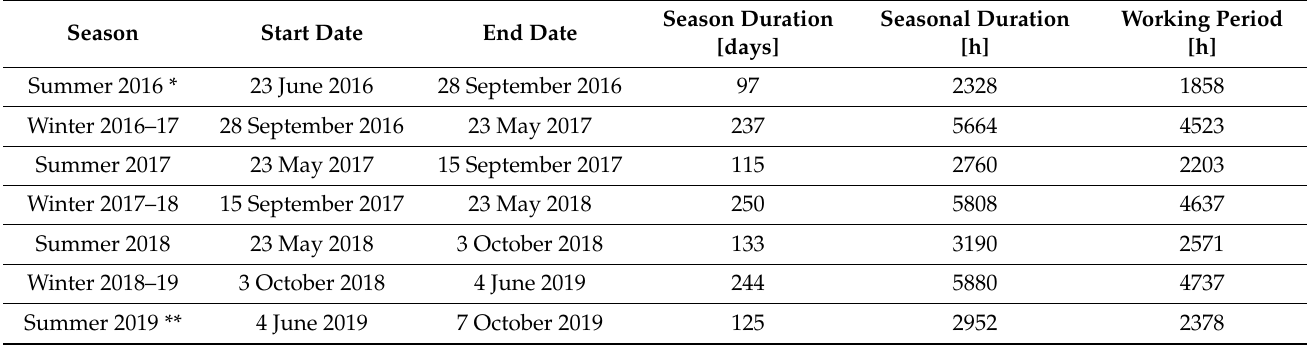
Table 1. Duration of the summer (cooling by geocoding) and winter (heating by GSHP) seasons monitored (elaborations based on [22]).